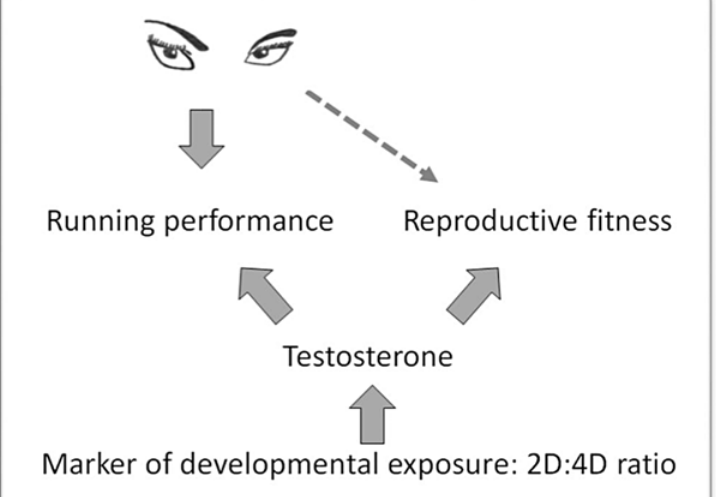
Fig 2. Conceptual diagram outlining a potential mechanism by which hunting success and running performance act as a signal of reproductive